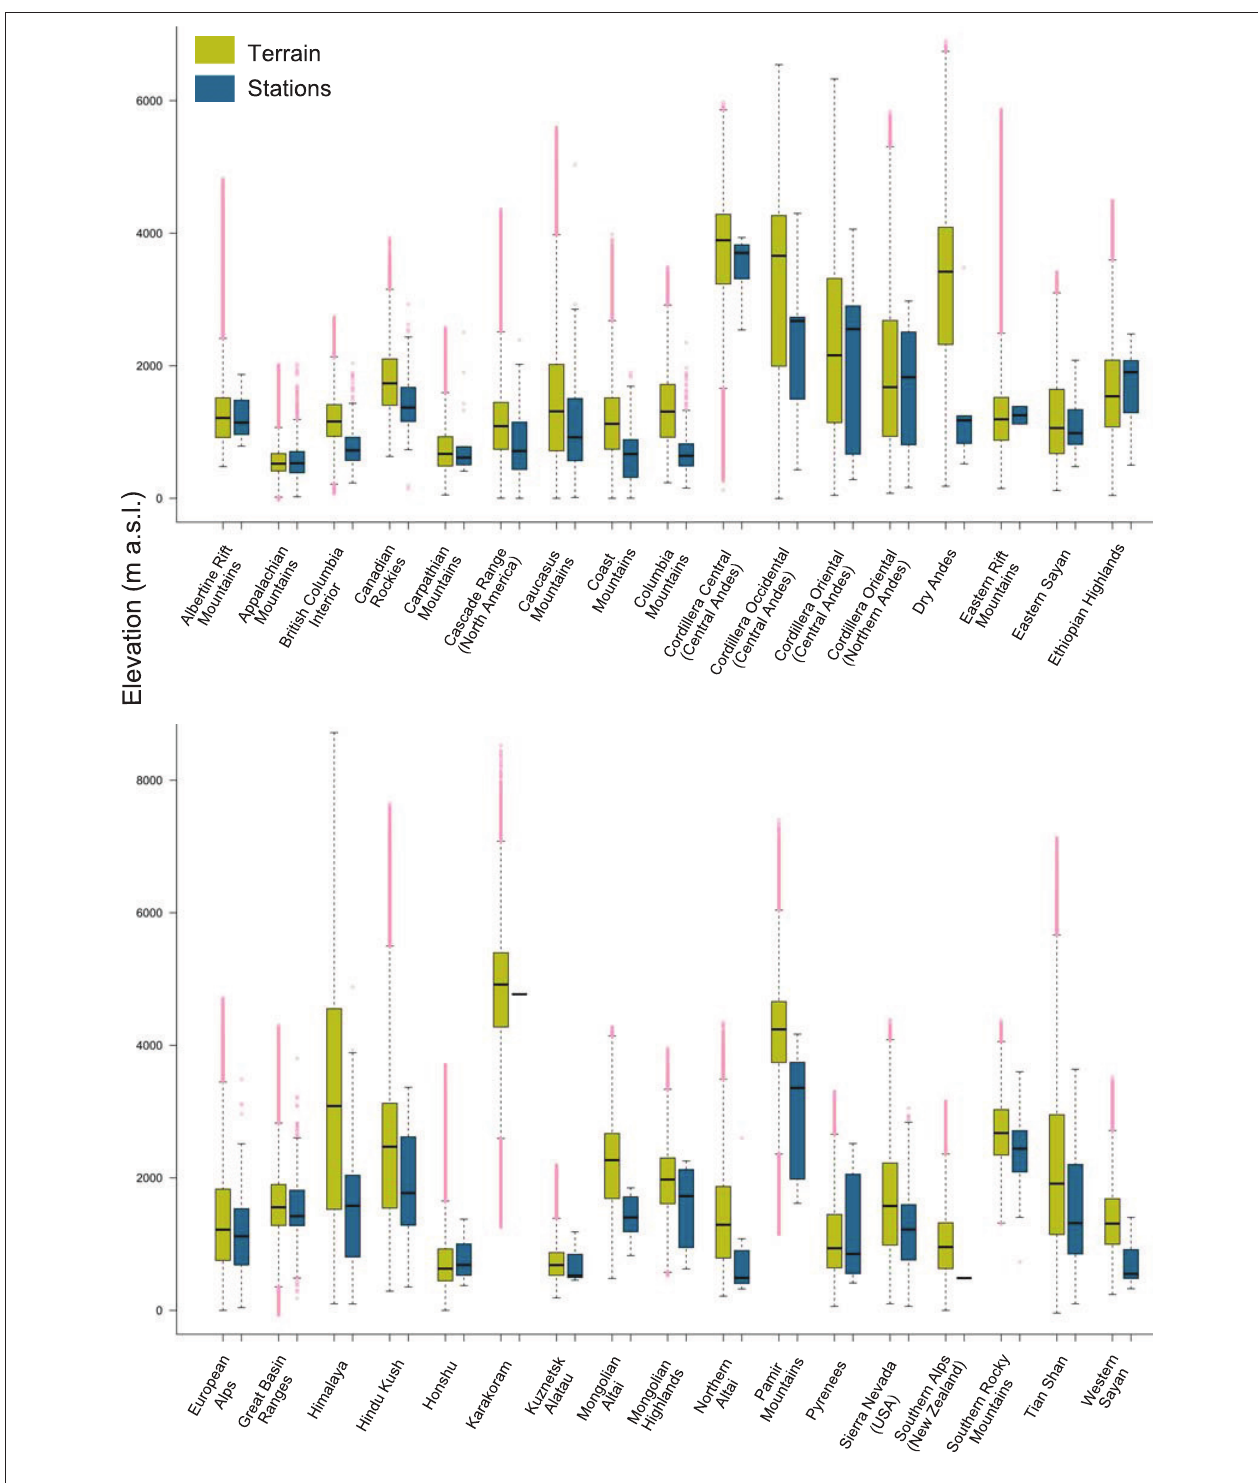
FIGURE 9 | Elevational coverage of GHCNd stations irrespective of variable or record length of the mountainous parts of 34 selected GMBA polygons relative to the underlying elevation distribution of those regions. Plots for all regions are provided in the online Supplementary Material.